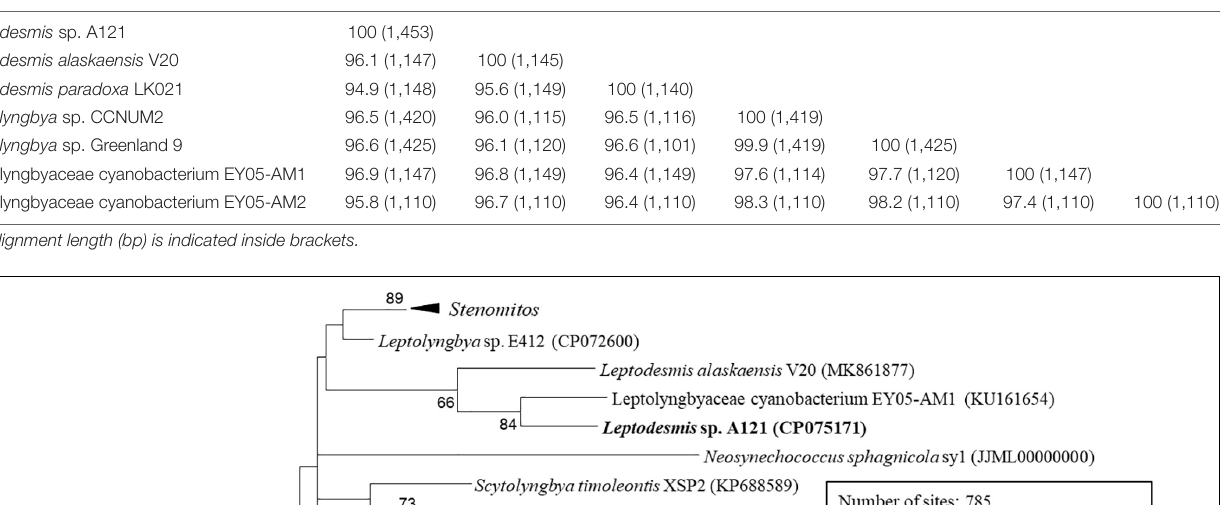
TABLE 1 | Sequence identities (%) of 16S rRNA gene of Leptodesmis strains studied. Strain